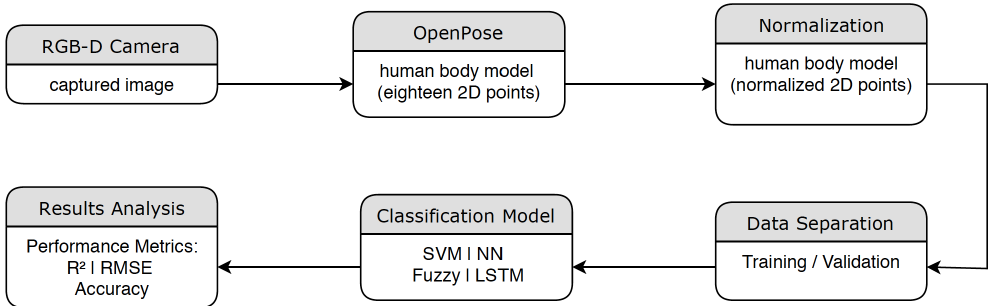
Figure 8. The workflow proposed in the paper to obtain the several models from the acquired data from images, for both human pose and activity detections. In the boxes, in gray are presented the main tasks and in white rectangles the data or sub-tasks are depicted.